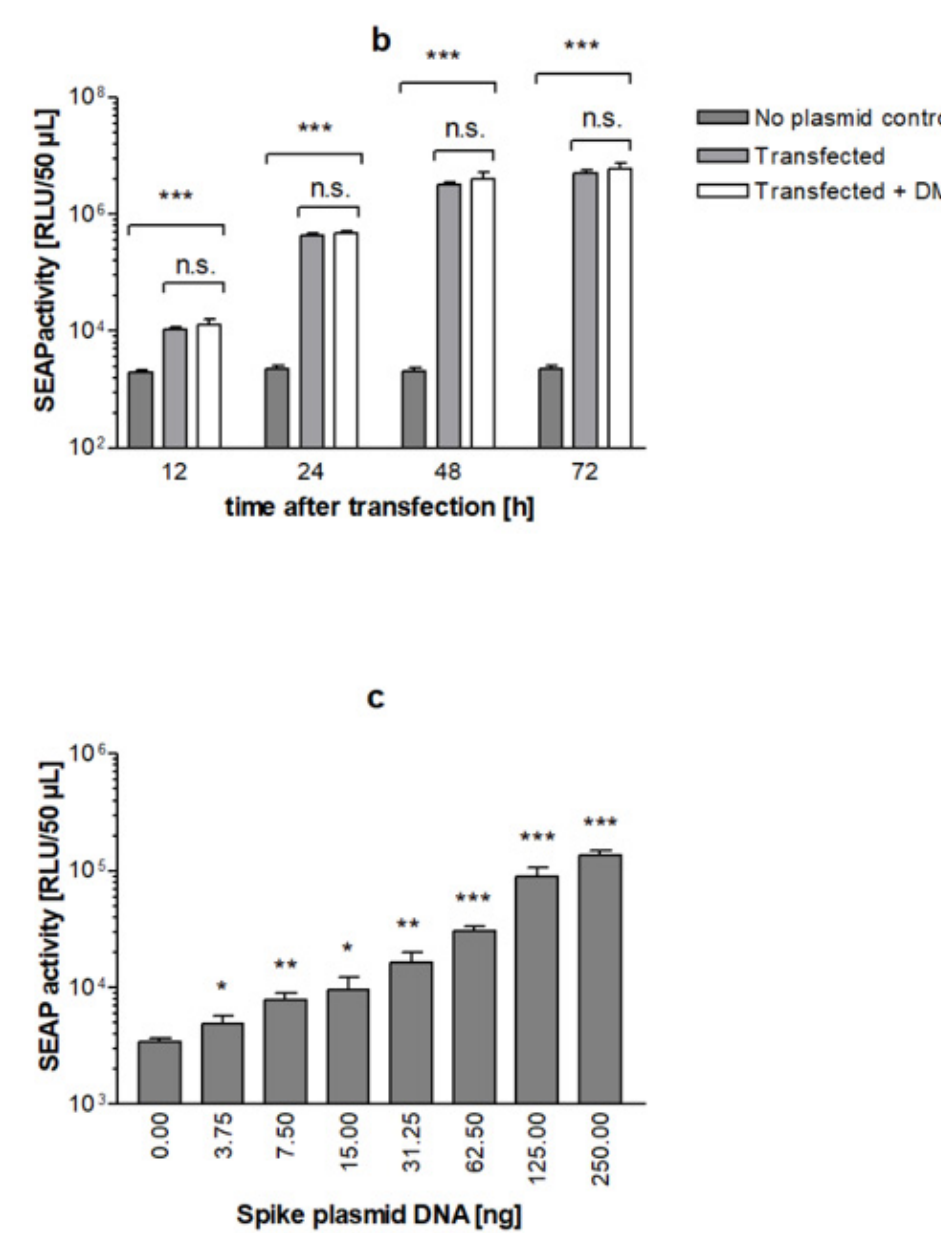
Figure 8. SARS-CoV-2 S protein induces syncytia formation and reporter gene expression in stable Vero reporter cells. ( a ) Reporter cells were transfected with 250 ng vector pCG1-SARS-2-S, fixed 24 h after transfection with formaldehyde 3.7%, and stained with SARS-CoV-2 IgG positive human serum/goat anti human IgG-FITC (green) and DAPI (blue); ( b ) time kinetics of SEAP-expression in SARS-CoV-2 transfected reporter cells cultivated in 24-well plates. Addition of DMSO 0.5% after transfection of cells (white bars) had no effect on SEAP levels; ( c ) Effect of plasmid quantity on SEAP activity measured 24 h post transfection. Significance is indicated compared to negative control. Data represent means ± SD from quadruplicate, p < 0.05 (*), p < 0.01 (**) and p < 0.001 (***).